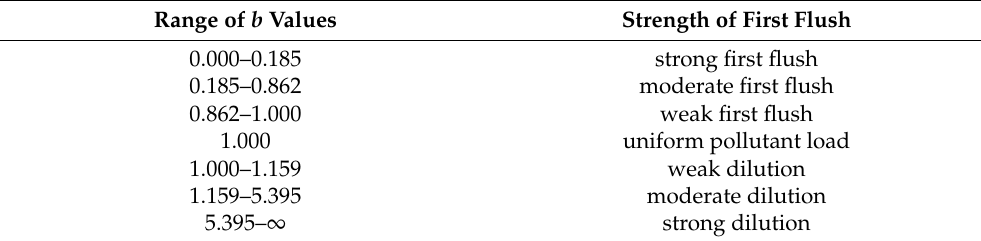
Table 1. Classification of the first flush strength according to Saget et al. [12] and Hathaway et al. [14]. Range of b